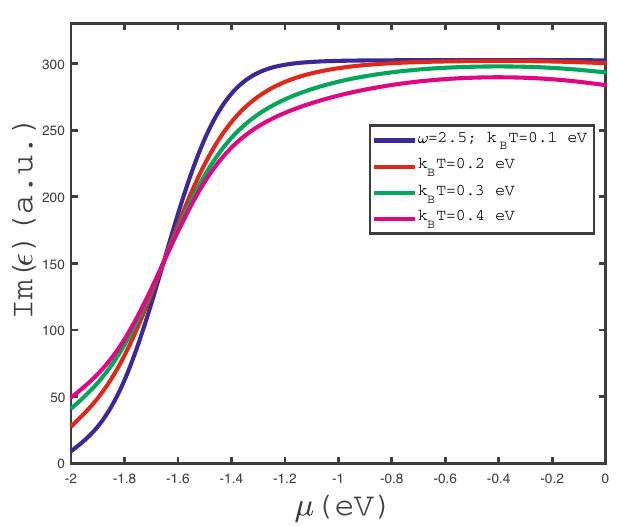
Figure 11. Optical absorption, Im (ǫ) , of doped MoS 2 layer as a function of chemical potential µ at fixed 2.5 eV for different values of temperature, namely k frequency ω = absence of